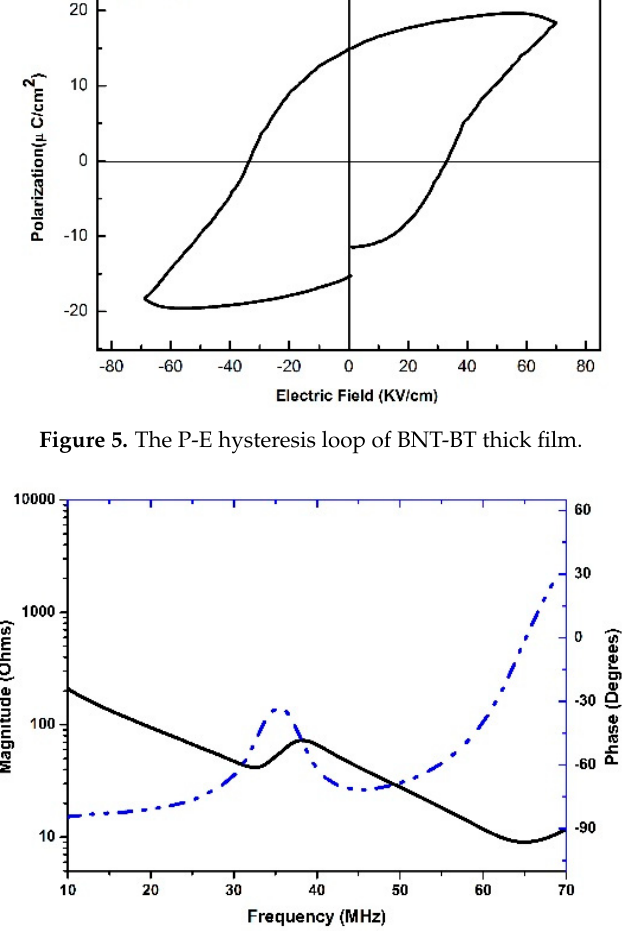
Figure 5. The P-E hysteresis loop of BNT-BT thick film.